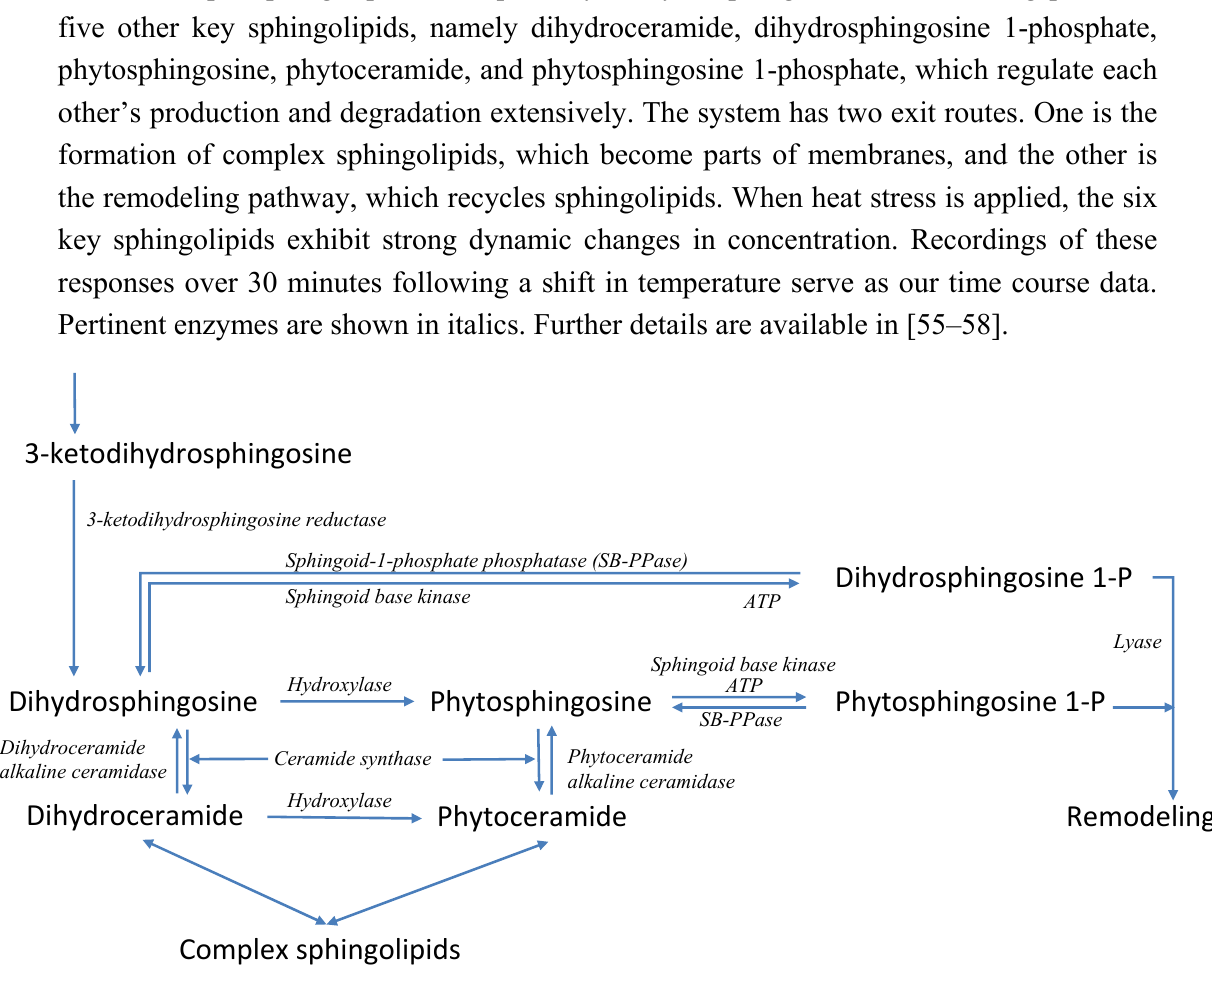
Figure 4. Simplified pathway system of sphingolipid biosynthesis and usage in yeast. Sphingolipid biosynthesis is initiated with the condensation of palmitoyl-CoA and serine, leading to 3-ketodihydrosphingosine, which is quickly converted into dihydrosphingosine, the first simple sphingolipid in the pathway. Dihydrosphingosine is the starting point for five other key sphingolipids, namely dihydroceramide, dihydrosphingosine 1-phosphate, phytosphingosine, phytoceramide, and phytosphingosine 1-phosphate, which regulate